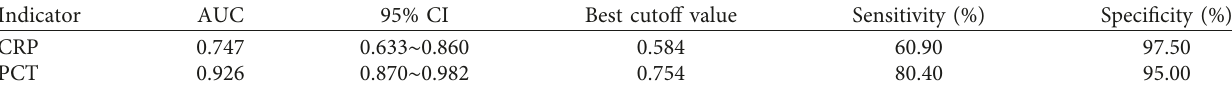
Table 3: Analysis of the value of serum CRP and PCT levels for the diagnosis of acute simple lower urinary tract infection. Indicator